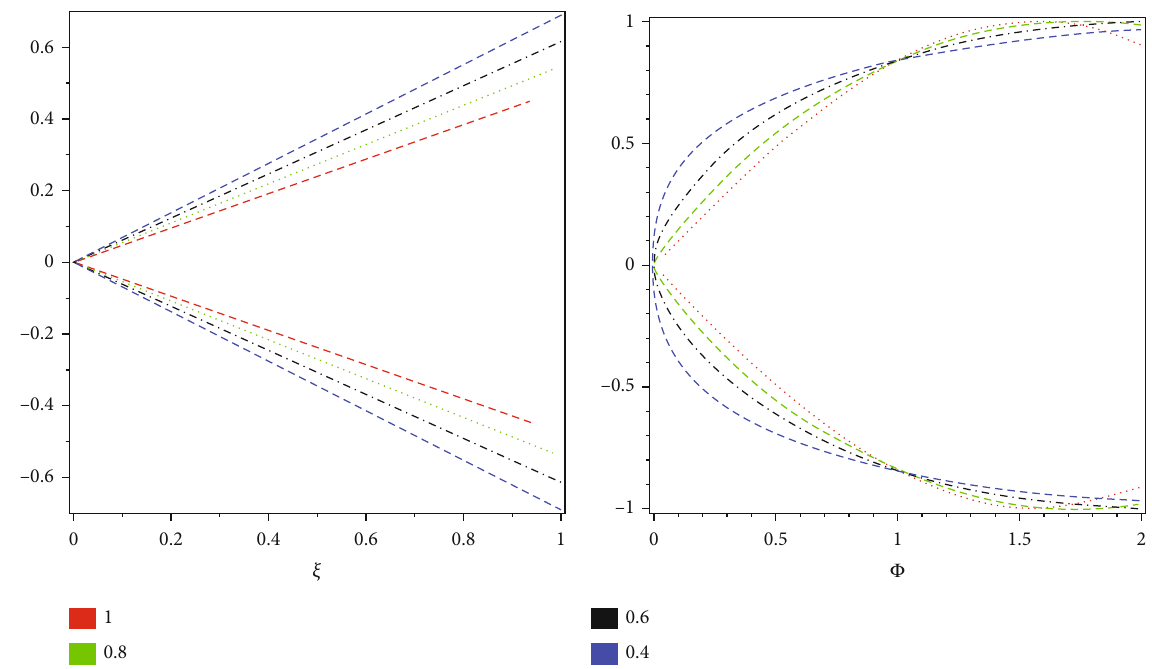
Figure 3: The fi rst graph depicts a two-dimensional fuzzy upper and bottom branch graph of an analytic series result with respect to space and time.